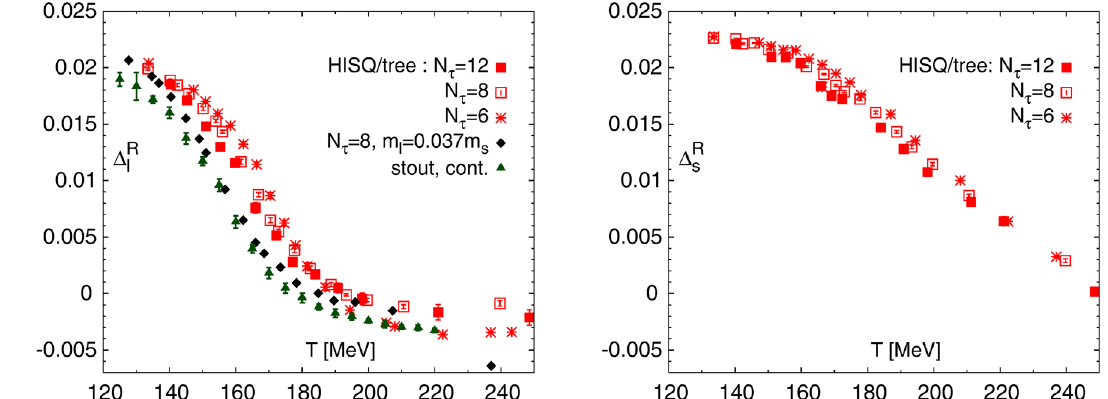
Fig. 1 Light- (left panel) and strange-quark (right panel) subtracted condensates around T c ∼ 155 MeV computed in [5,6]. They are defined as (cid:8) (cid:9) (cid:13) R = d + 2 m − (cid:7) ¯ ψψ (cid:8) (cid:7) ¯ ψψ (cid:8) 4 , with ψ = q , s and d , r 1 lattice parameters defined in [6]. Figure taken from [6] s r T 0 l , s 1